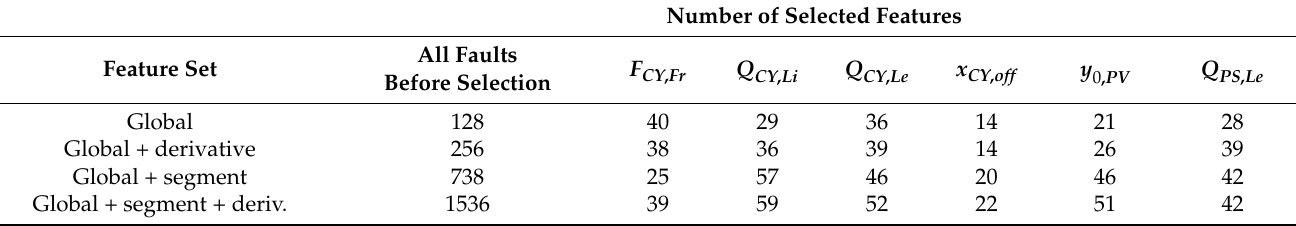
Table 5. Number of features before and after feature selection for the different feature sets and different faults.